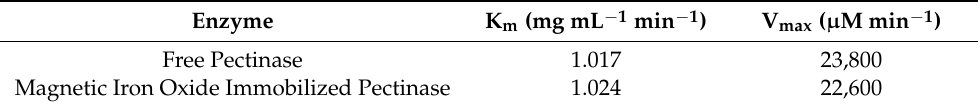
Table 1. Kinetic Parameters of magnetic iron oxide nanocarrier immobilized and free pectinase. Enzyme